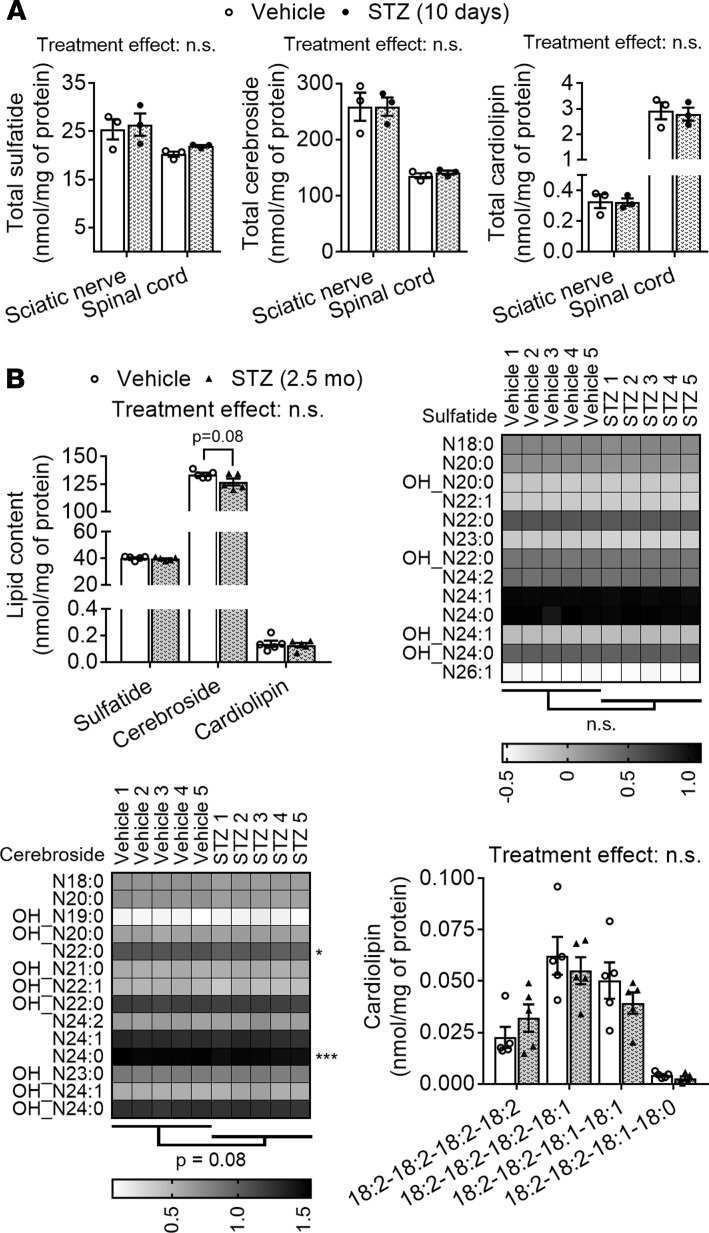
Insulin deficiency–induced hyperglycemia does not alter nerve mitochondrial/myelin lipid homeostasis.Sciatic nerve and spinal cord tissue from vehicle and insulin-deficient STZ-treated mice were lipid extracted and assessed by shotgun lipidomics. Tissue was harvested 10 days after a single high dose of STZ (filled circles/bars) or vehicle (open circles/bars (A) or 2.5 months after multiple low doses of STZ or vehicle (B). Total sulfatide, cerebroside, and cardiolipin content in sciatic nerve and spinal cord tissue from high-dose short-term STZ-treated mice. Total sulfatide, cerebroside, and cardiolipin content in sciatic nerves from low-dose long-term STZ-treated mice. Detailed analyses of sulfatide, cerebroside (CBS) and cardiolipin molecular species. Low-abundance lipid species that made ≤1% of the total class content are not shown and were not included in statistical analyses. In addition, very low-abundance sciatic nerve cardiolipin molecular species with mass levels ≤ 0.01 nmol/mg of total protein content were excluded. Although a specific mass peak may represent >1 molecular species, for simplicity heatmaps display only the most common lipid species for each peak (row). Graphs are presented as dot plots with bars; each dot represents 1 animal; data represent the mean ± SEM of n = 3 and 5 mice/group. Molecular species are presented as log-transformed gray scale heatmaps. Molecular species within each lipid class were compared using 2-way ANOVA and Holm-Šidák multiple-comparisons tests on GraphPad Prism 7. Statistics displayed below the heatmaps compare treatments and next to the molecular species are based on nontransformed data. *P < 0.05.